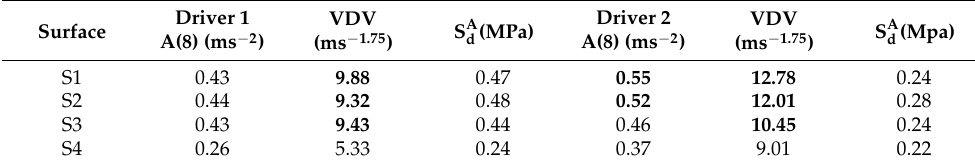
Table 12. Summary of health risk results obtained by ISO 2631-1 and ISO 2631-5.